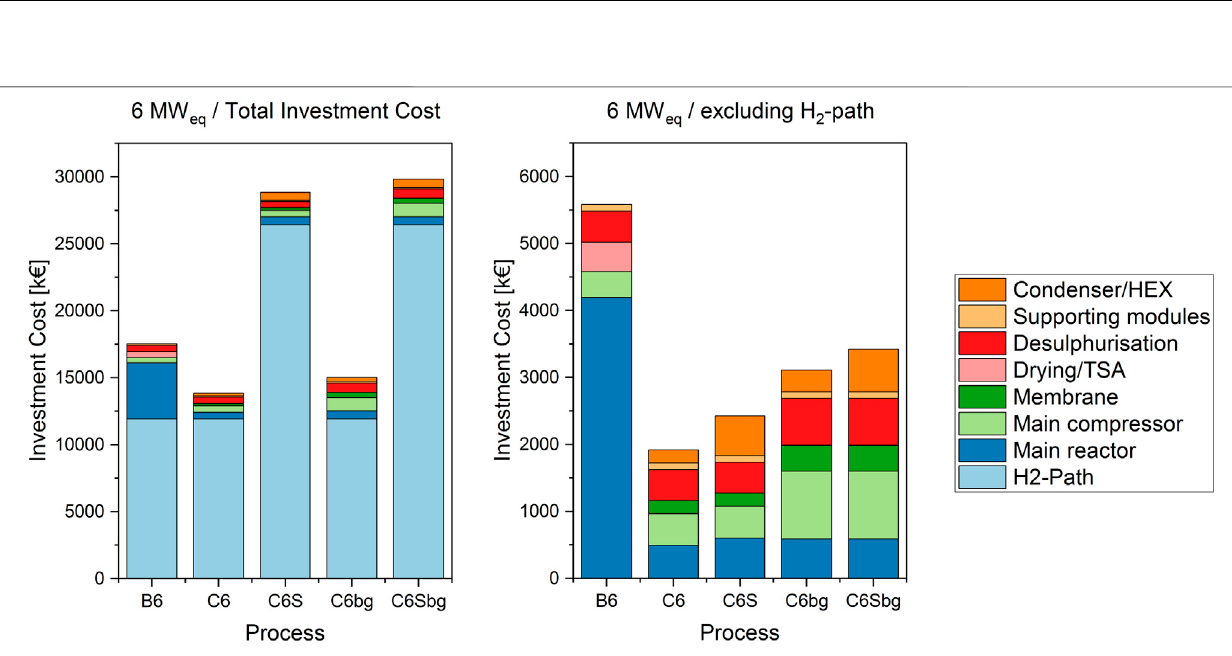
Frontiers in Energy Research |